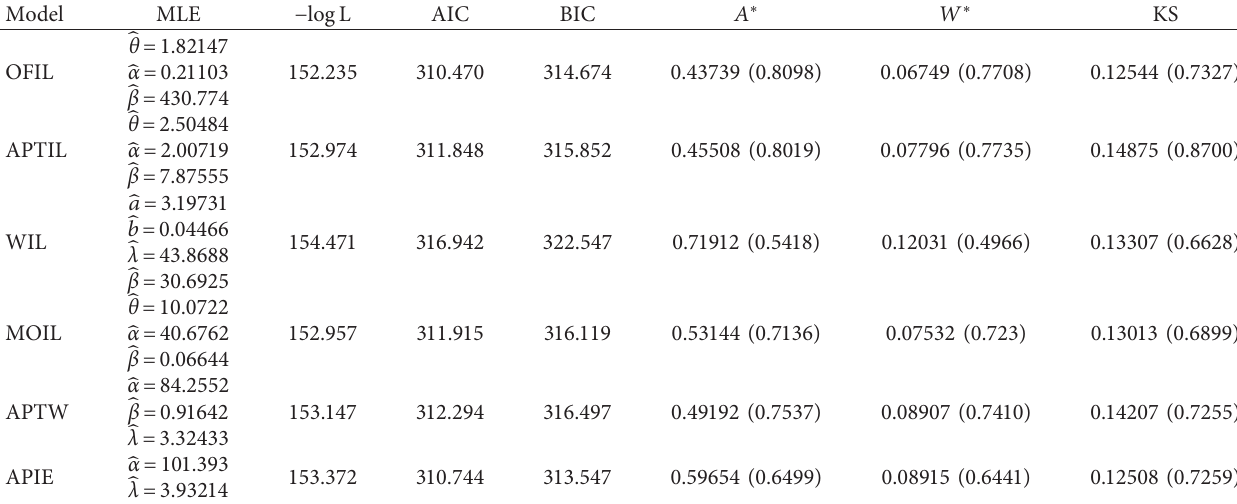
Table 13: ML estimates along with goodness of fit for data set